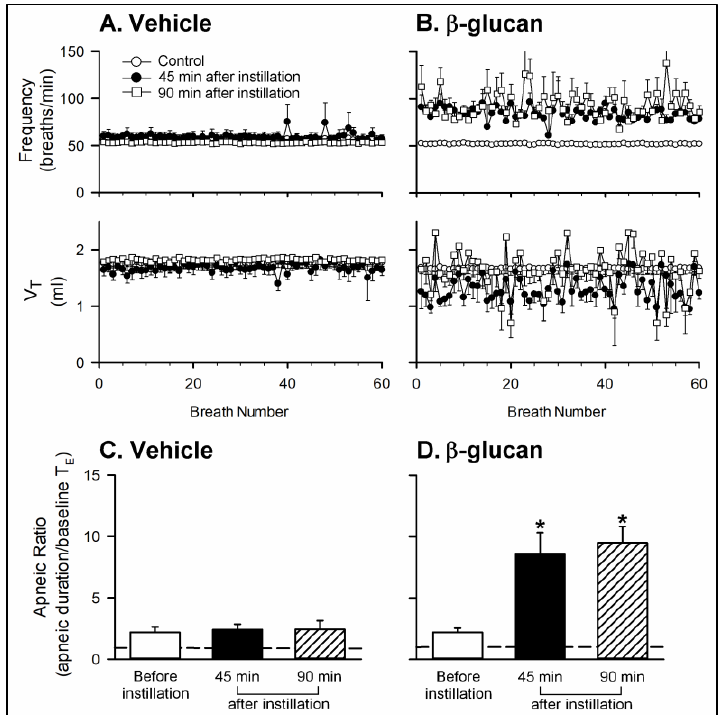
Figure 2. Effects of intratracheal instillation of β-glucan or its vehicle on the baseline breathing pattern and apneic response to right-atrial injection of capsaicin in two groups of anesthetized, spontaneously breathing rats. ( A ) and ( B ): effects of intratracheal instillation of vehicle or β-glucan on the baseline frequency and V T , respectively; ( C ) and ( D ): effects of intratracheal instillation of vehicle or β-glucan on the apneic responses to capsaicin injection, respectively. The apneic ratio was defined as the apneic duration occurring during 20 sec after the capsaicin injections divided by the baseline expiratory duration (T E ). Data are means ± SE ( n = 6). One-way ANOVA followed by Newman-Keuls post hoc test: *, significantly different from before instillation ( p < 0.05). Please note that the β-glucan instillation caused an irregular baseline breathing pattern, characterized by high respiratory frequency and unstable V T ; β-glucan also enhanced the apneic responses.